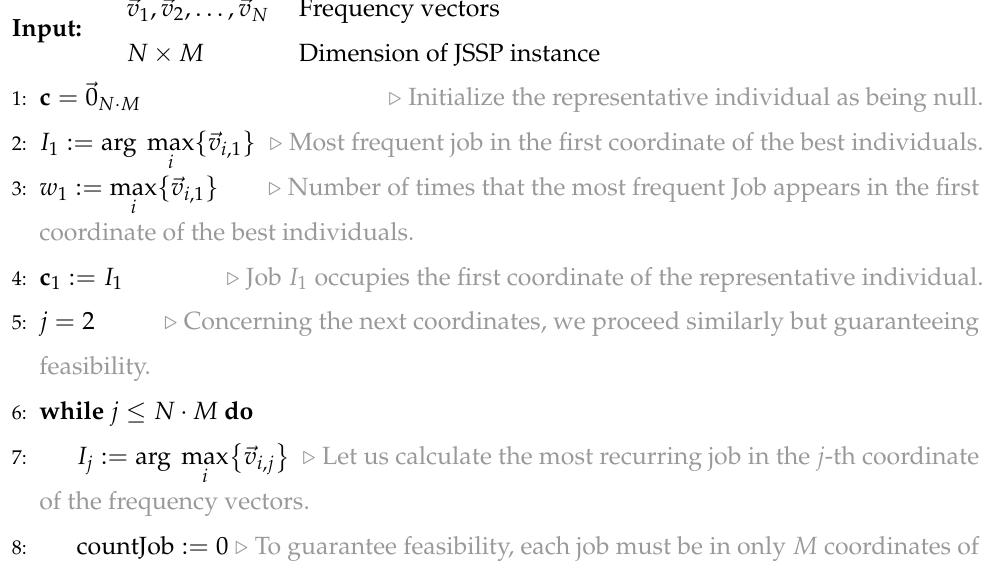
Algorithm 3 Calculating the representative individuals and their genetic